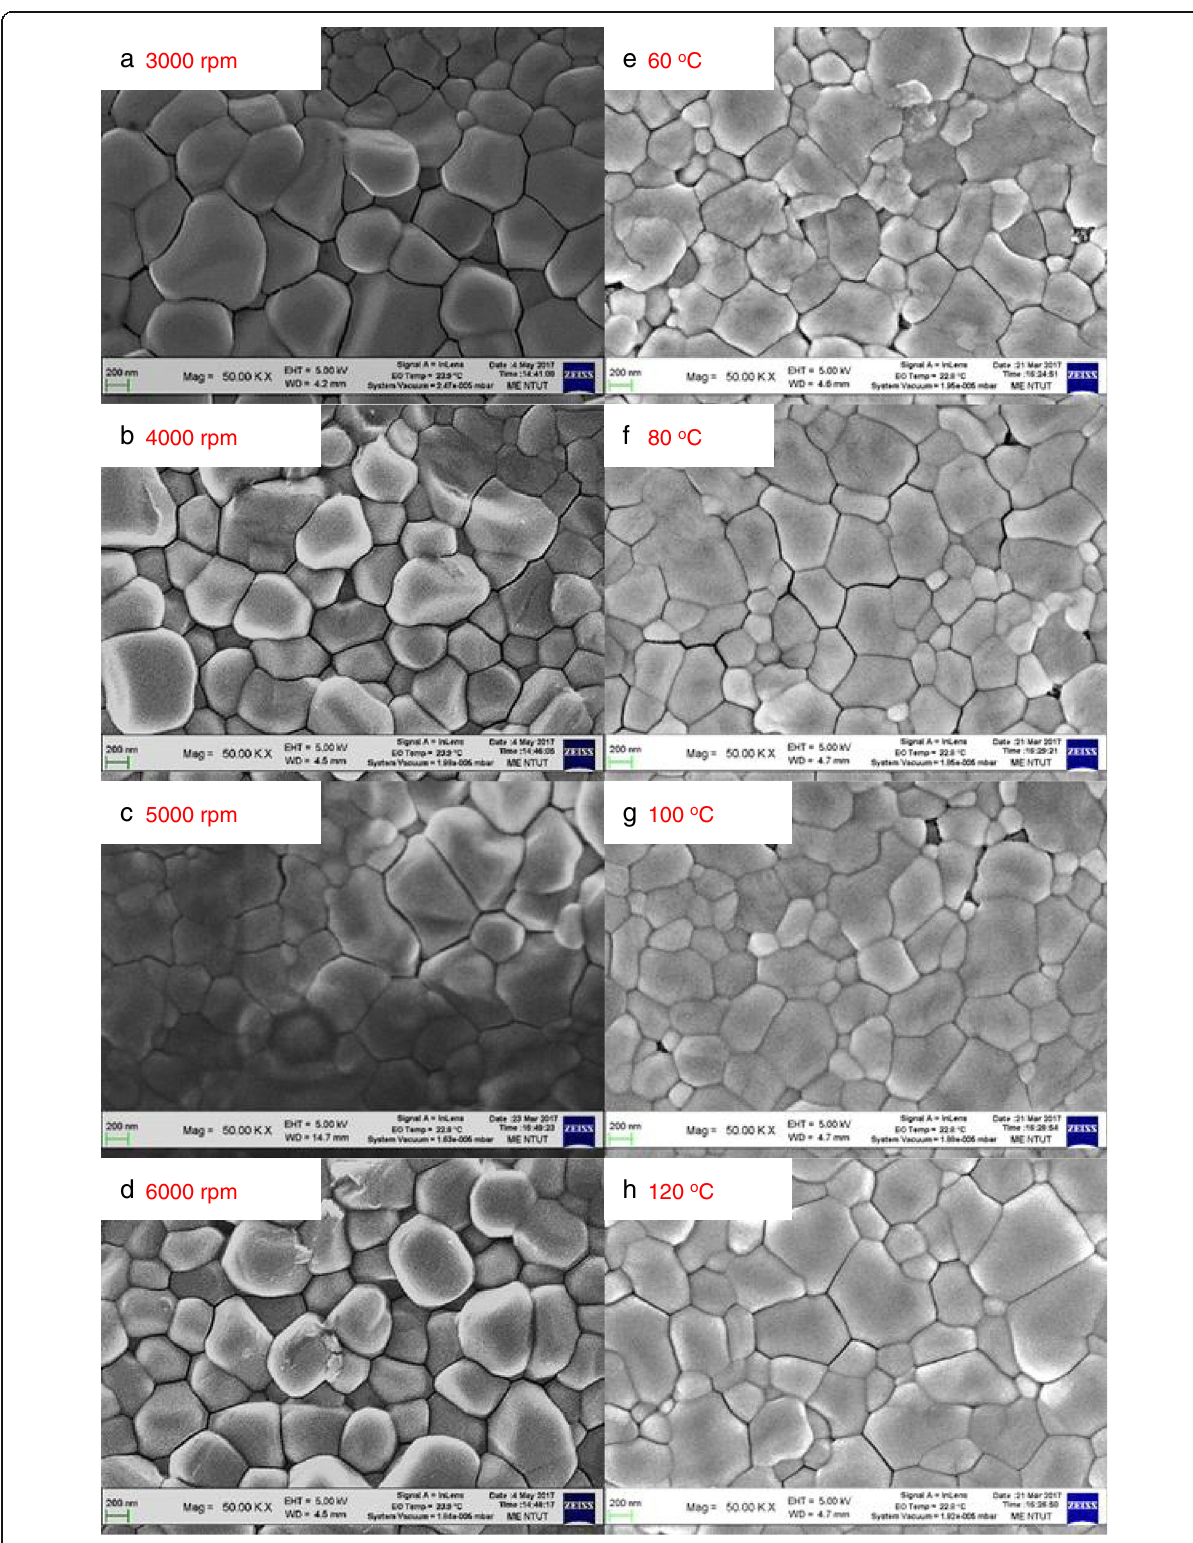
Fig. 3 Top-view SEM images of the MAPbI 3 perovskite films prepared by high-concentration MAI (10 mg/mL) with a-d various spin coating speeds and e-h annealing